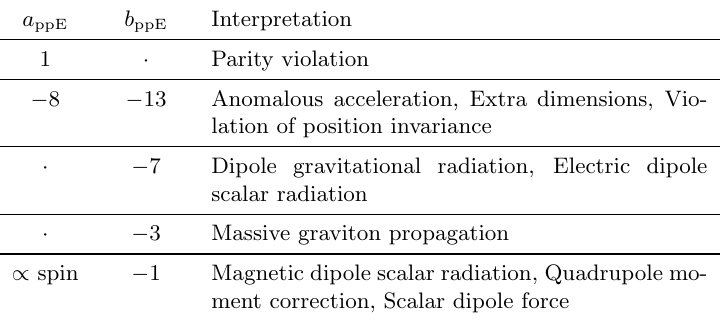
Table 4: Interpretation of non-zero ppE parameters. 𝑎 ppE